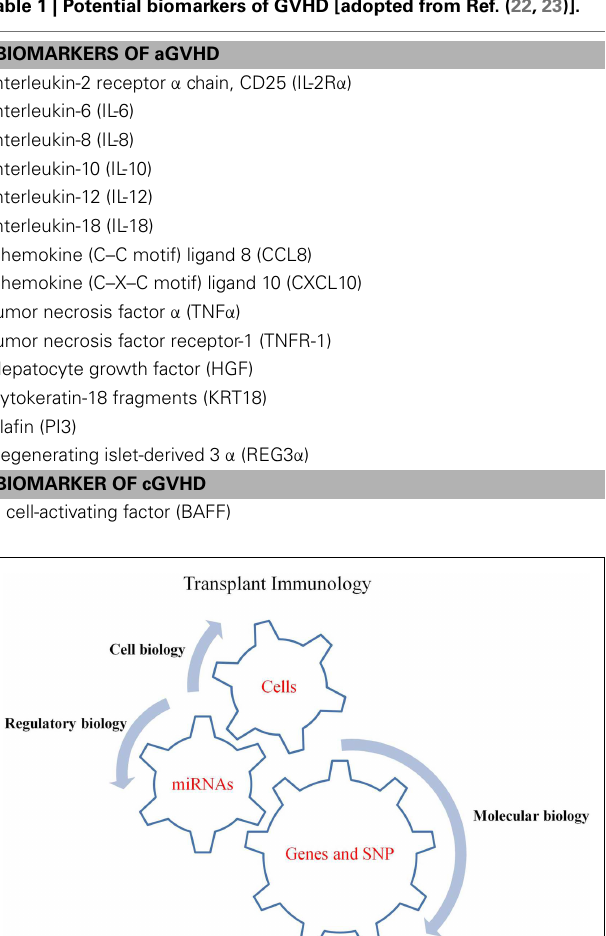
Table 1 | Potential biomarkers of GVHD [adopted from Ref. (22, 23)].